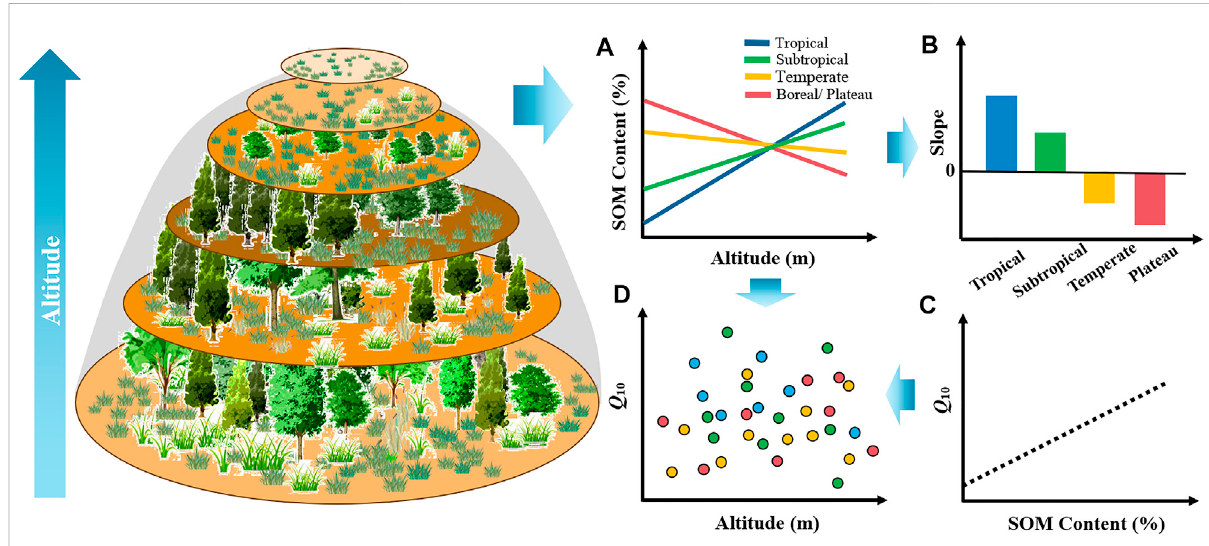
FIGURE 1 Hypothesized altitudinal variation of soil organic matter (SOM) content and Q 10 values in different climatic zones. The left side represents a schematic diagram of the change of vegetation with increasing mountain altitude. (A) Trend of SOM content with altitude increases in different climatic zones; (B) slope of SOM content with increasing altitude in different climatic zones; (C) relationship between SOM content and Q 10 , where the black line shows the positive correlation between SOM and Q 10 ; (D) variation in altitudinal Q 10 with increasing altitude on a global